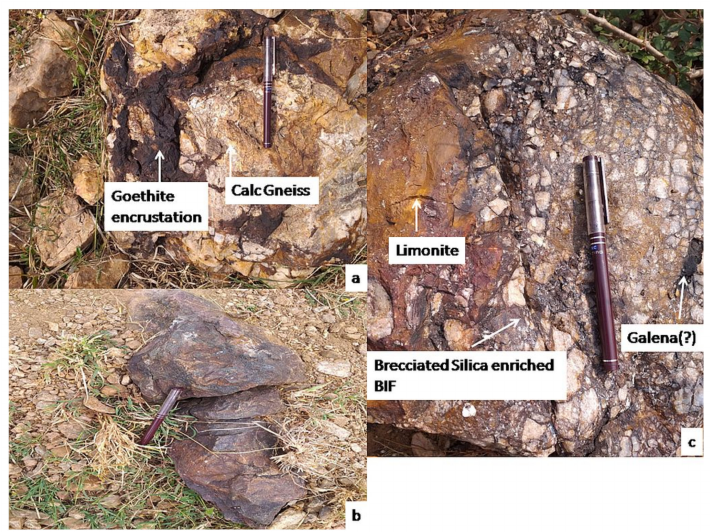
Figure 11. ( a ) Gossanized (goethite intruded) unclassified calcareous silicates near Baran area. ( b ) Sur- face exposures of BMQ, near Baran village. ( c ) Brecciated and altered BMQ hosting mineralization (presence of Galena, ore of lead), near Baran village.